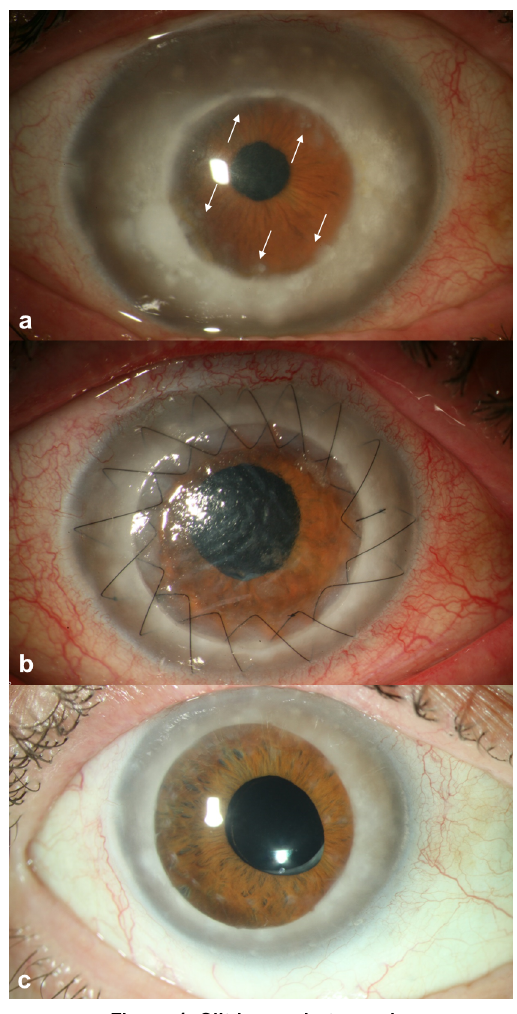
Figure 1: Slit lamp photographs a) Recurrence of macular corneal dystrophy on the corneal graft’s periphery (6 mm diameter, arrows); thickened host cornea with whitish deposits; b) Postoperative findings 4 days after surgery; graft with Descemet folds after excimerlaser-assisted repeated penetrating keratoplasty (8.0/8.1 mm diameter with double running cross-stitch suture according to Hoffmann); c) Clear corneal graft 40 months after repeated penetrating keratoplasty and 23 months after all-sutures-out; visual acuity